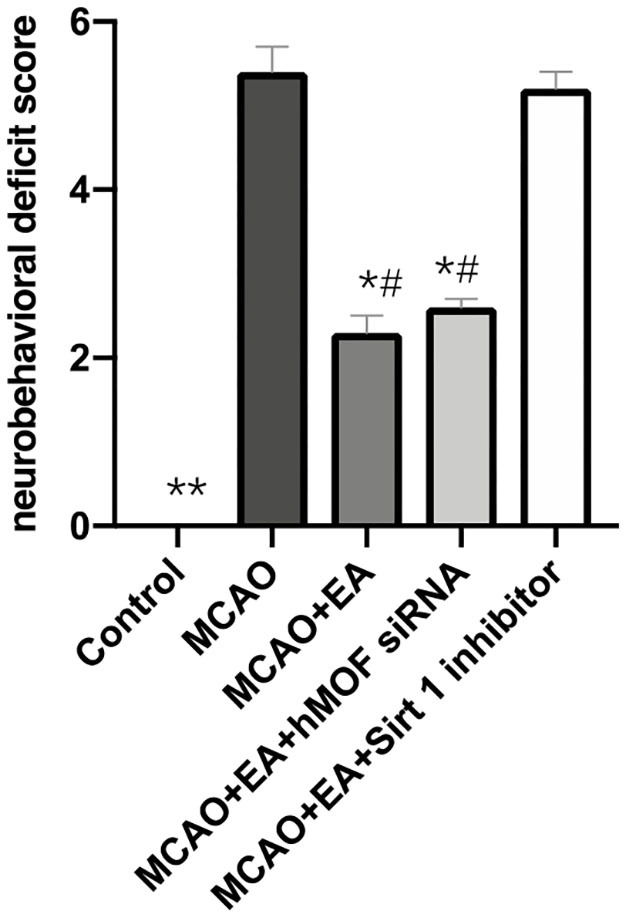
Electroacupuncture improves neurological scores. Data are presented as means ± SEM; n = 24 rats per group, *P < 0.01, **P < 0.001, vs. the MCAO group; #P < 0.01, vs. the MCAO+EA+Sirt1 inhibitor group.